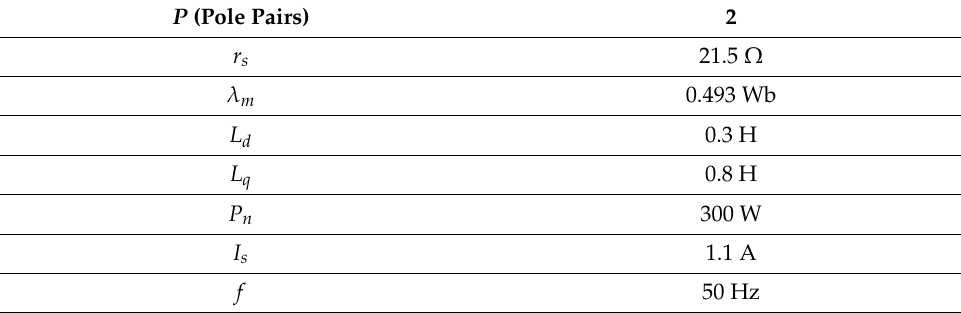
Table 1. Parameters of the